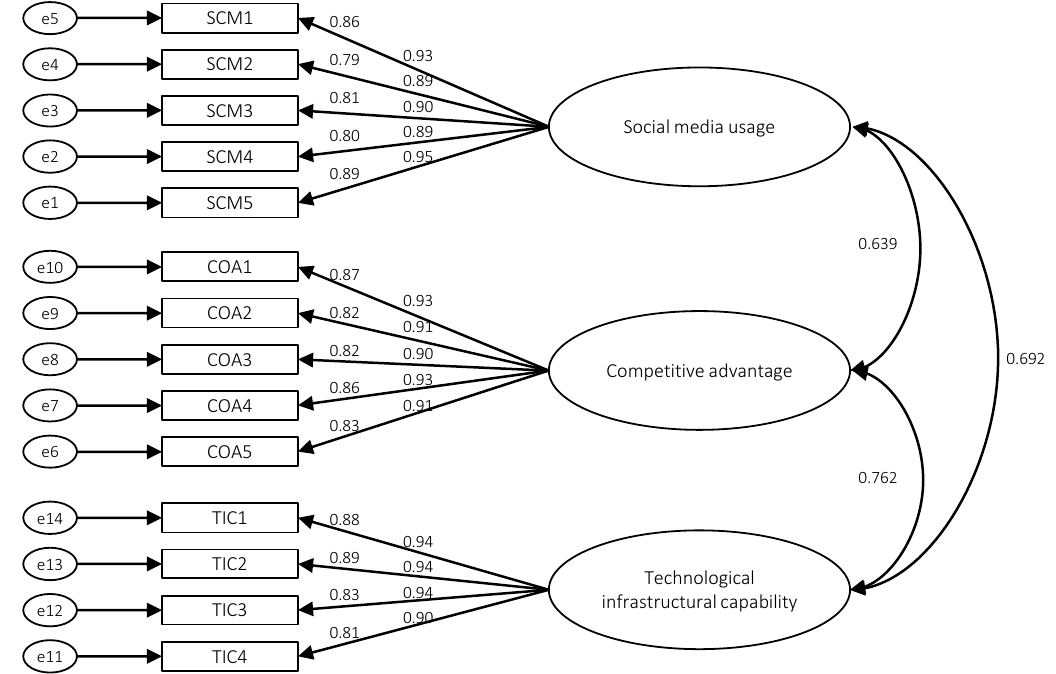
Figure 1. Confirmatory factor